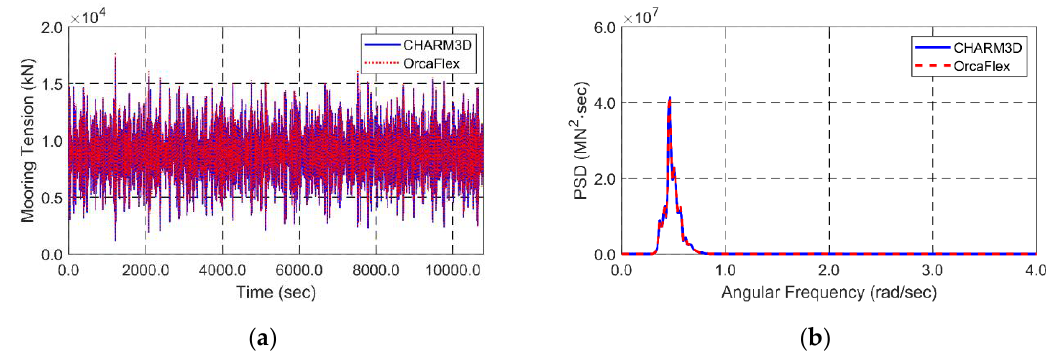
Figure 9. Time histories ( a ) and spectrum ( b ) of mooring tension (#3) in the middle location under the 100-year-strom waves. Table 3. Statistics of the SFT motions and mooring tensions at the middle location under 100-yr irregular wave excitations (from the time series of Figures 7 – 9).